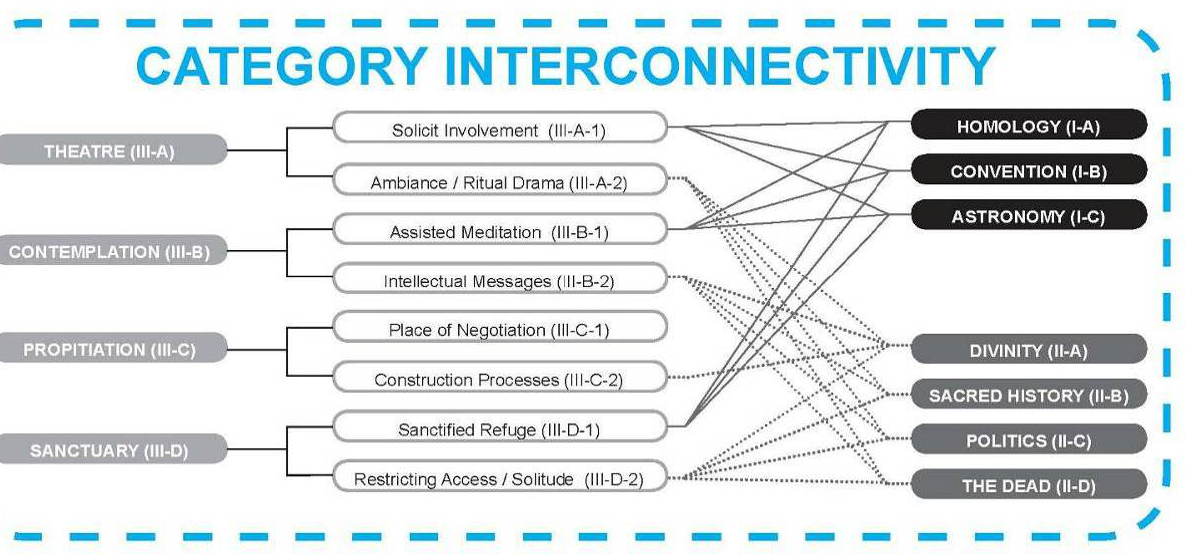
Figure 1. Diagram by author demonstrating the interconnectivity between ritual contexts ( left ) and other categories ( right ) within Lindsay Jones’ “morphology of ritual-architectural priorities” (2000). The subcategories for each ritual context ( center ) illustrate how the connections are made to both allurement based strategies ( top-right ) and commemorative based categories ( bottom-right ).